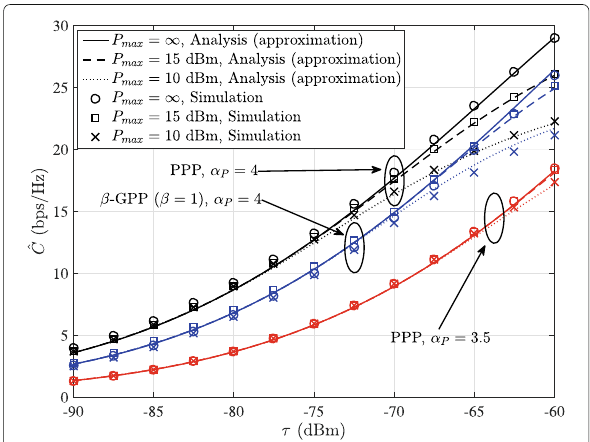
Fig. 7 Impact of the intensity of PBSs λ P on the total average SU achievable rate ˆ C